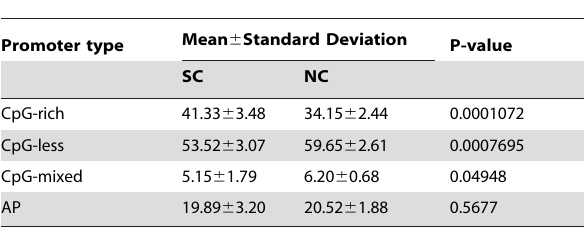
Table 10. The distribution of promoter usage; CpG-richness and AP usage are considered to highlight differences between SCs and non SCs.